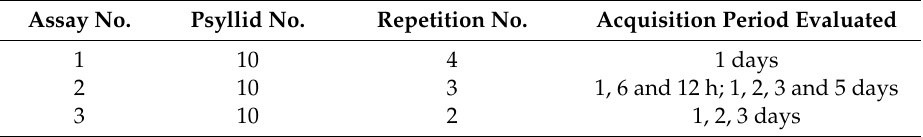
Table 1. CaLsol acquisition access period (AAP) by T. erytreae in infected carrot plants. Assay No. Psyllid No. Repetition